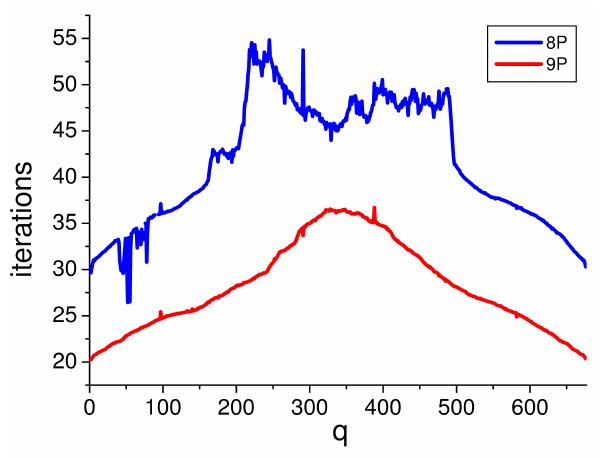
Figure 6. Average iteration number as a function of the guess accuracy for the 8P (blue) and 9P (red) cases. The cases with q = 1 and q = 670 correspond to using one of the nearest neighbors as an initial guess, while q = 335 corresponds to using diametrically opposite